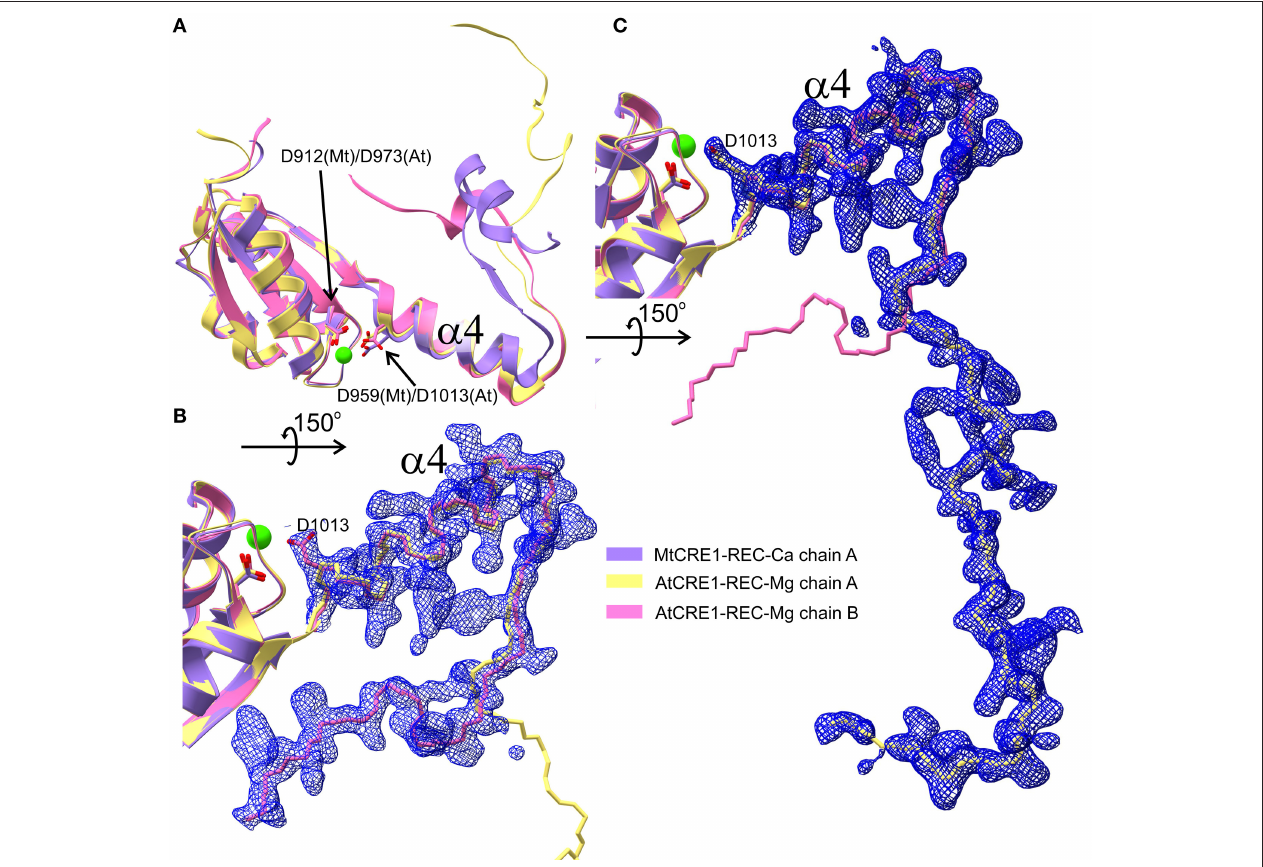
FIGURE 5 | Three different conformations of the CRE1-REC swapping domain are superposed in (A) (cartoon representation), as found in MtCRE1-REC (purple), AtCRE1-REC chain A (yellow) and AtCRE1-REC chain B (pink). The open C-terminus of the AtCRE1-REC structure and its 2mFo-DFc electron density map contoured at the 1 σ level is shown for subunit A (C) and subunit B (B) with the C α traces in yellow and pink, respectively. The clear electron density fully supports the postulate of conformational change events taking place along the 3D domain swapping